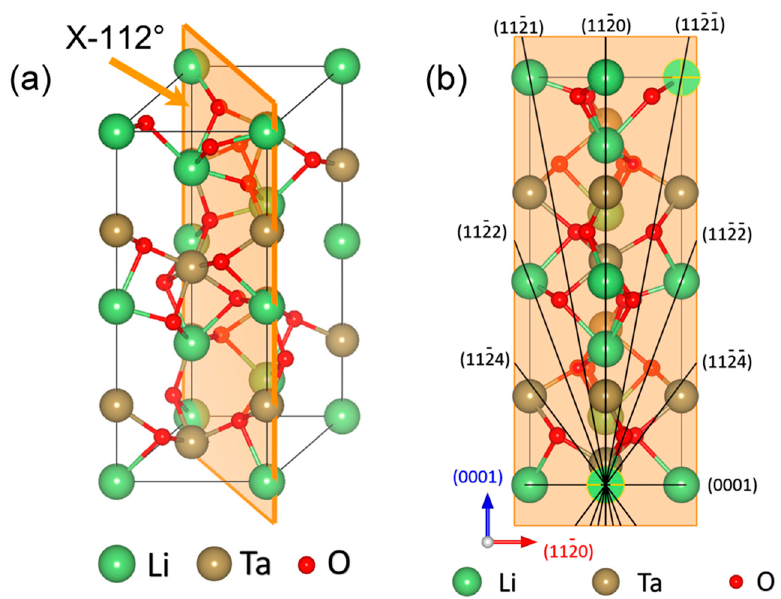
Figure 1. ( a ) Schematic illustration of atomic arrangements of LiTaO 3 single crystal, the X-112° plane ( 1(cid:3364) 102) is depicted. ( b ) Slip system perpendicular to the X-112° plane.